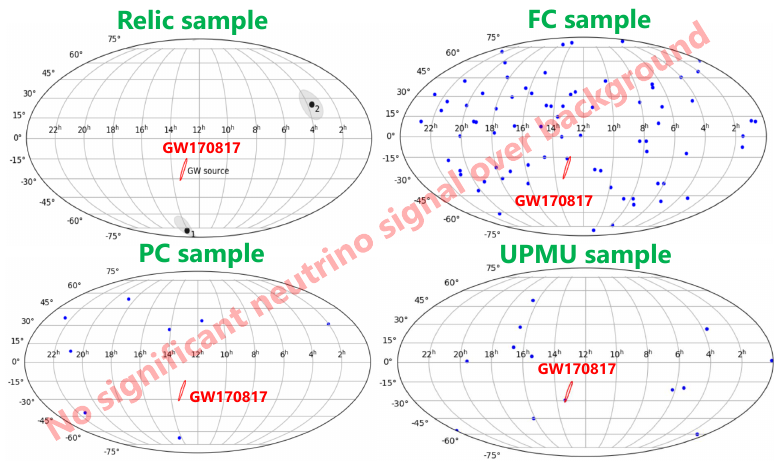
Figure 3. Sky map of the observed events in the 14-day time window. The points (red contour) show the observed events (location of